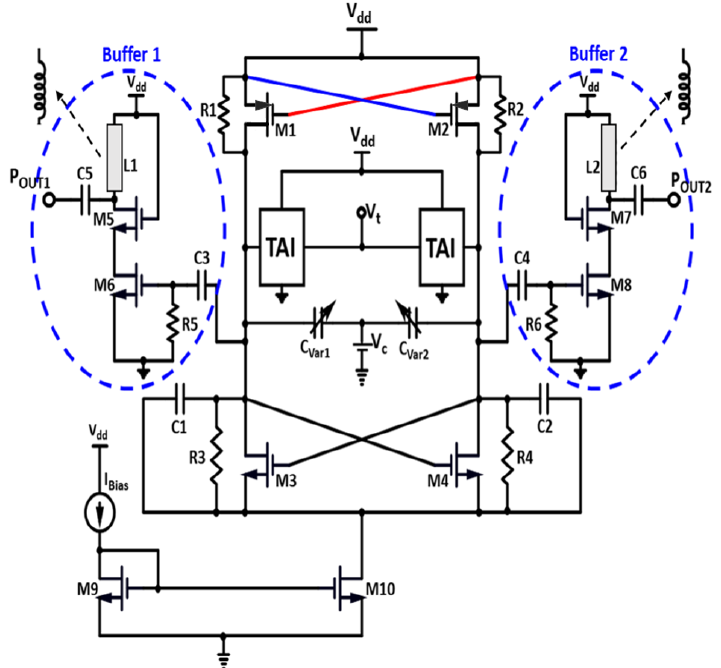
Figure 7. Schematic diagram of the proposed